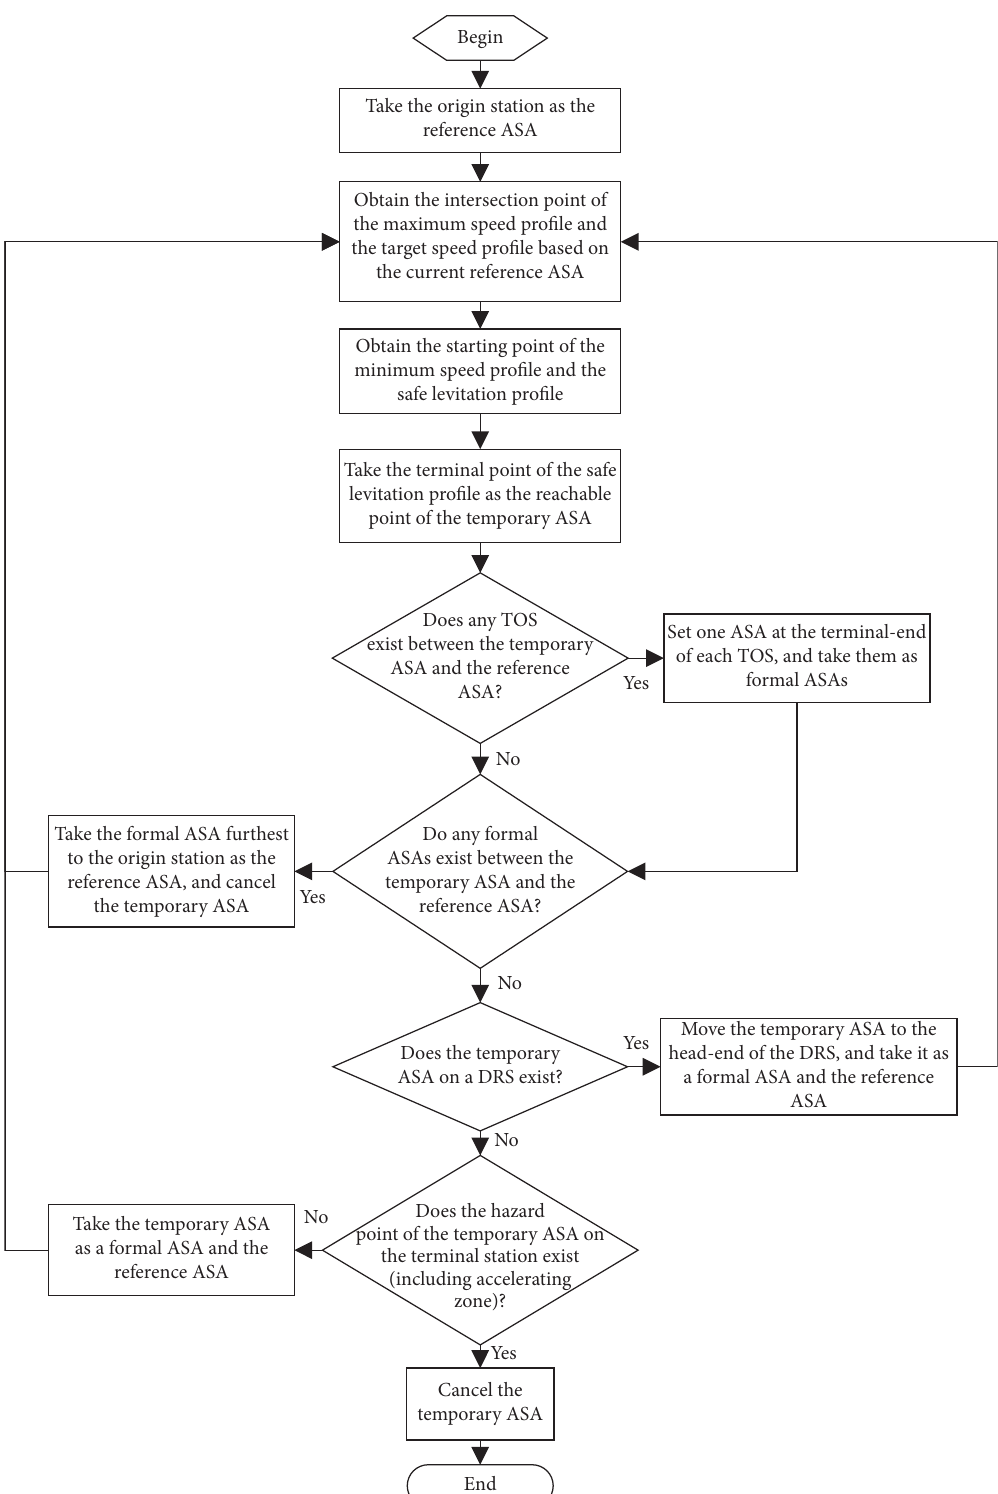
Figure 7: ASA layout starting from the origin